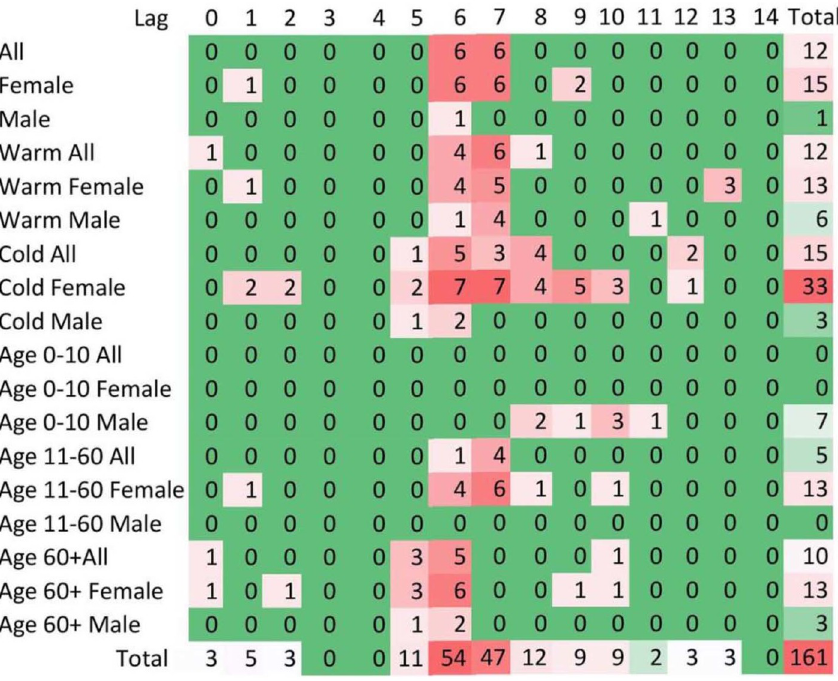
Fig 3. Total frequencies of all associations for ambient air pollutants and the number of ED visits for related episodic and paroxysmal disorders (G40-G47). Eighteen strata (classified by patients’ sex and age, as well as cold vs. warm seasons) examined and arranged in the rows, and 15 lags (expressed as days) are arranged in columns. For visual representation: 0 (green) colour represents other than positive statistically significant associations.